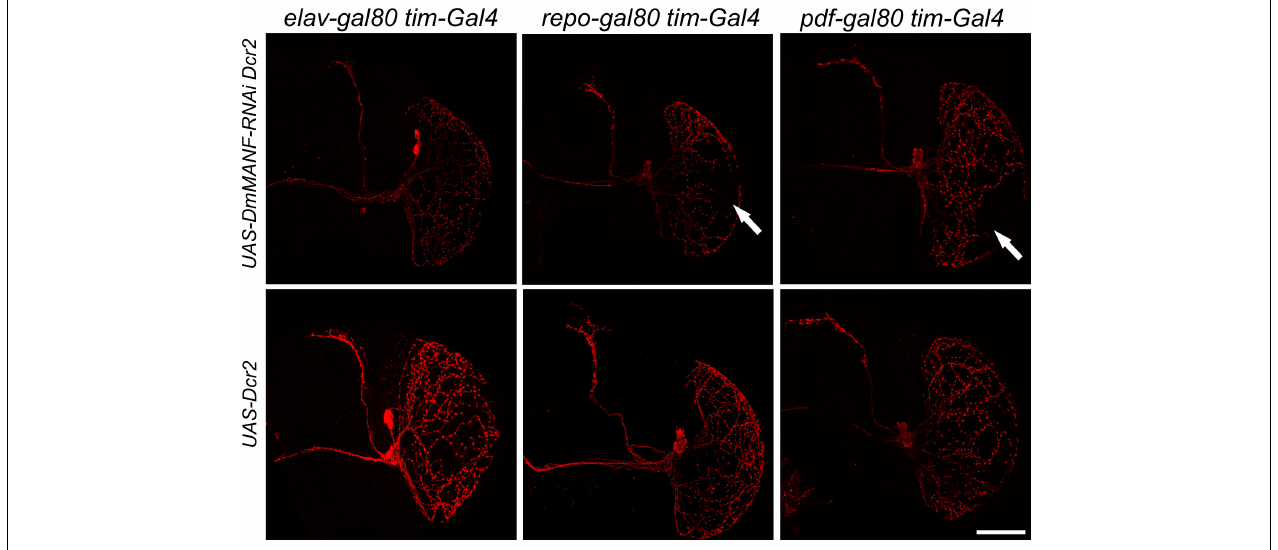
FIGURE 5 | Morphology of PDF-expressing neurons after inhibition of DmMANF expression in tim -positive cells in combination with different GAL80 lines. Morphology of PDF-positive neurons after expression of UAS-DmMANF-RNAi and Dicer2 (upper row) or Dicer2 alone as the control (bottom row) in tim -positive glia (left column), tim -positive neurons (middle column) and tim -positive cells excluding PDF-expressing pacemakers (right column). Solid arrows show the lack of l-LNv projections in the medulla. N = 9. Scale bar: 50 µ m.